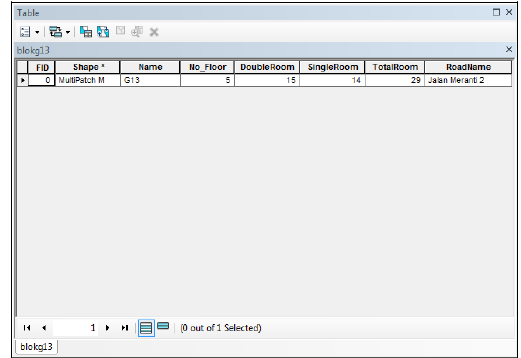
Figure 12 The database of Block G13, KRP, UTM